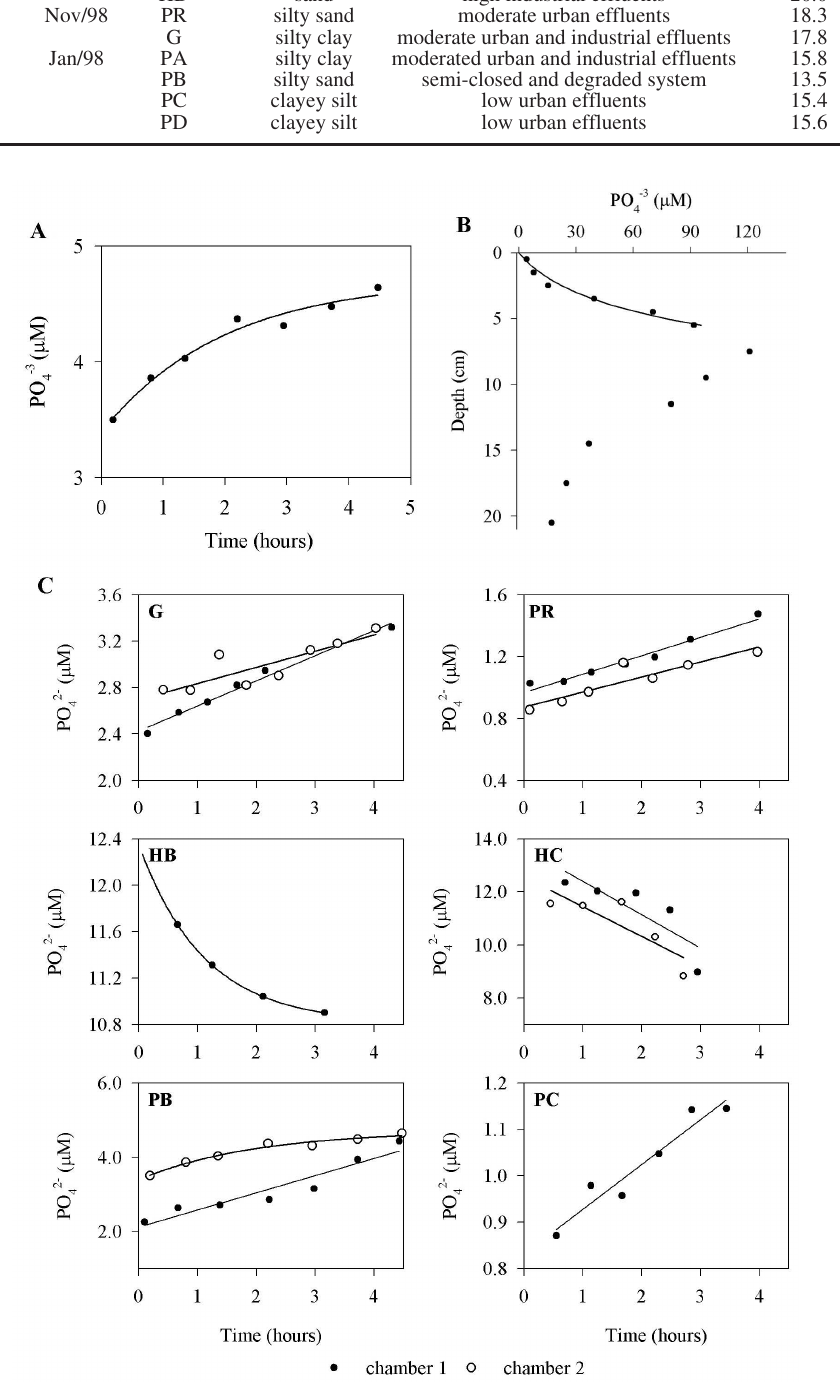
Fig . 2. – Variations in phosphate concentration inside the benthic chamber (A) and in the interstitial water (B) at station PB. (C) Variations in phosphate concentration inside the benthic chambers at two stations for each system studied. Exponential/linear fits used for the calculation of the benthic and diffusive fluxes have been superimposed on the experimental data.